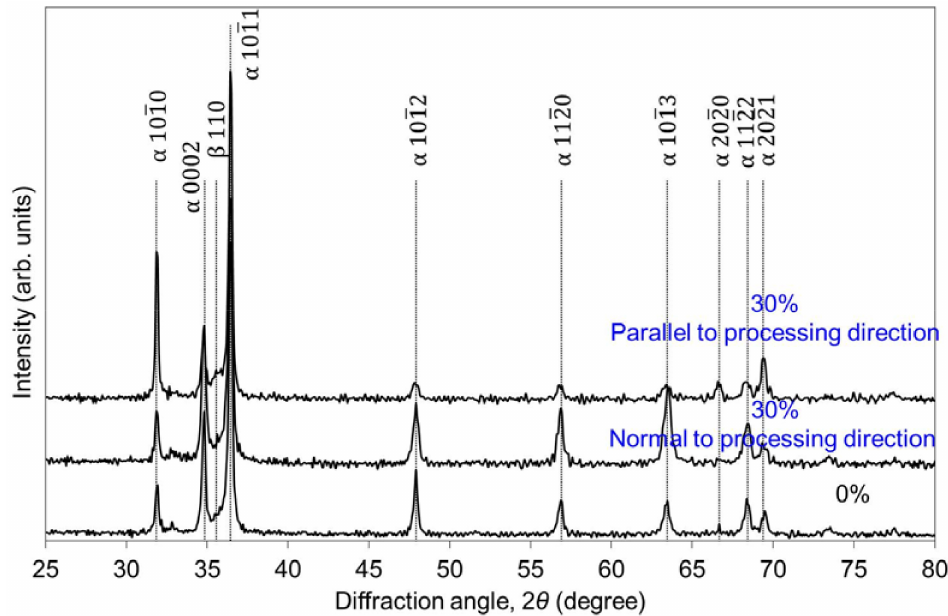
Figure 3. XRD profiles of Zr–1Mo alloy specimens extracted parallel and normal to the processing direction with an area reduction of 30%, compared to the profile of an unswaged Zr–1Mo